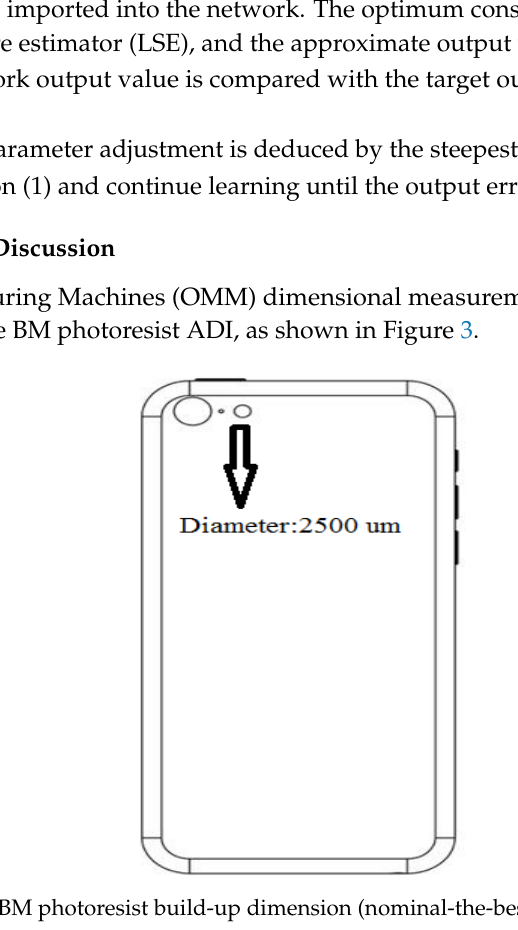
Figure 3. The BM photoresist build-up dimension (nominal-the-best; diameter: 2500 um).